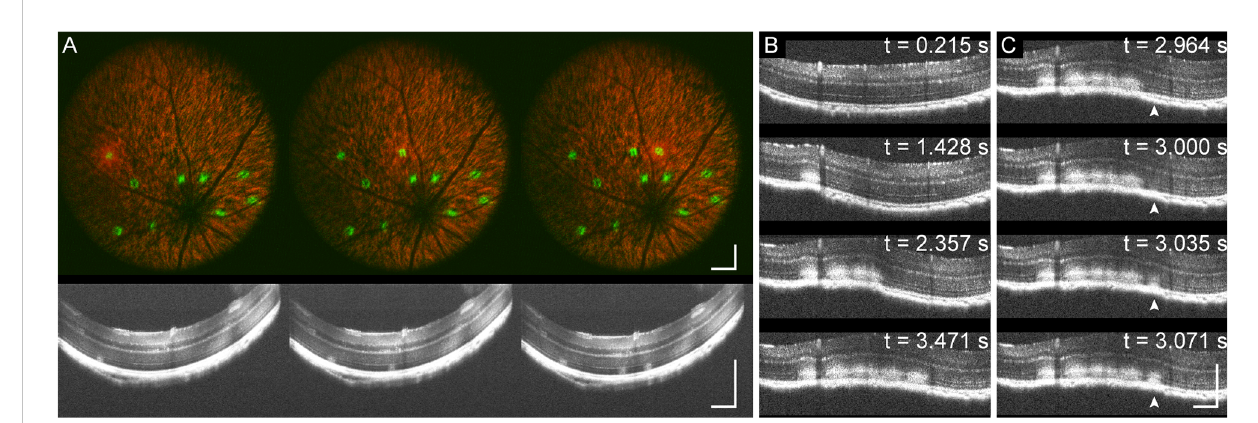
FIGURE 6 MURIN imaging of laser lesion dynamics. (A) Video-rate imaging of photodamage with 4 successive 6 mW 200 ms duration laser pulses at each location shows increasing fl uorescence photoconversion on SLO and scattering contrast on OCT cross-sections (Supplemental Video 1). (B) Higher